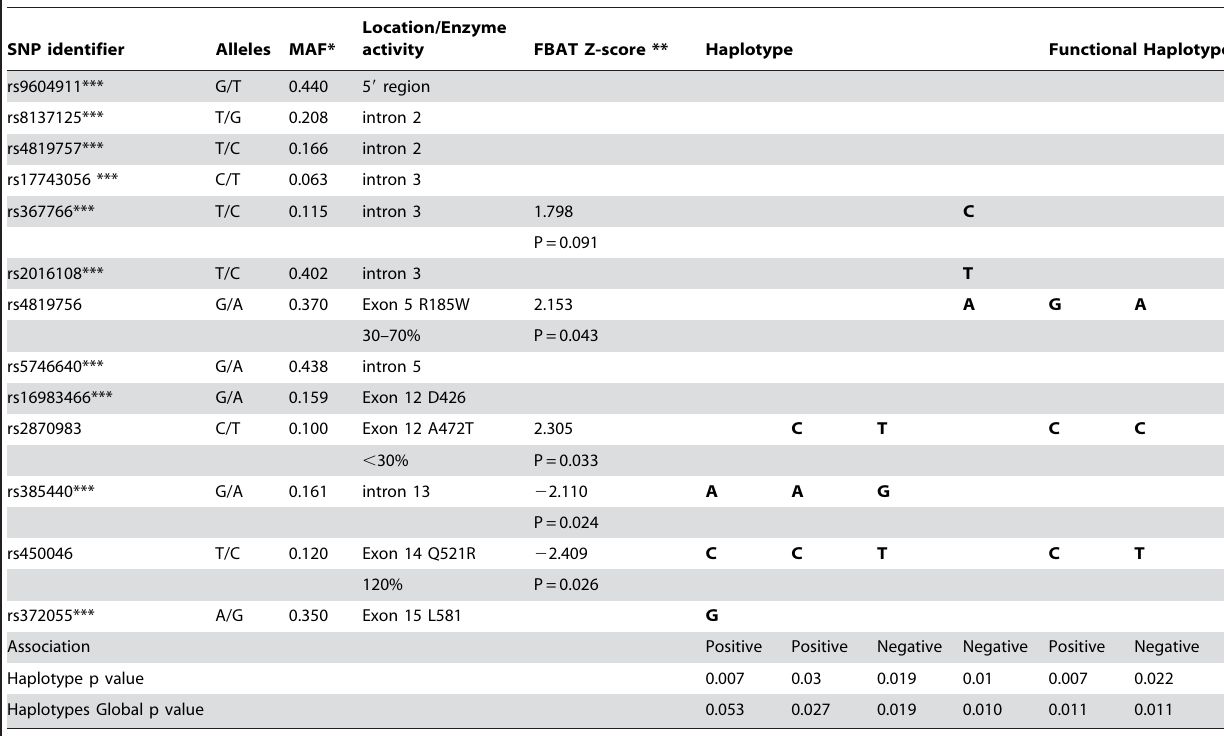
Table 1. Single SNP and Haplotype Clinical Association Results.